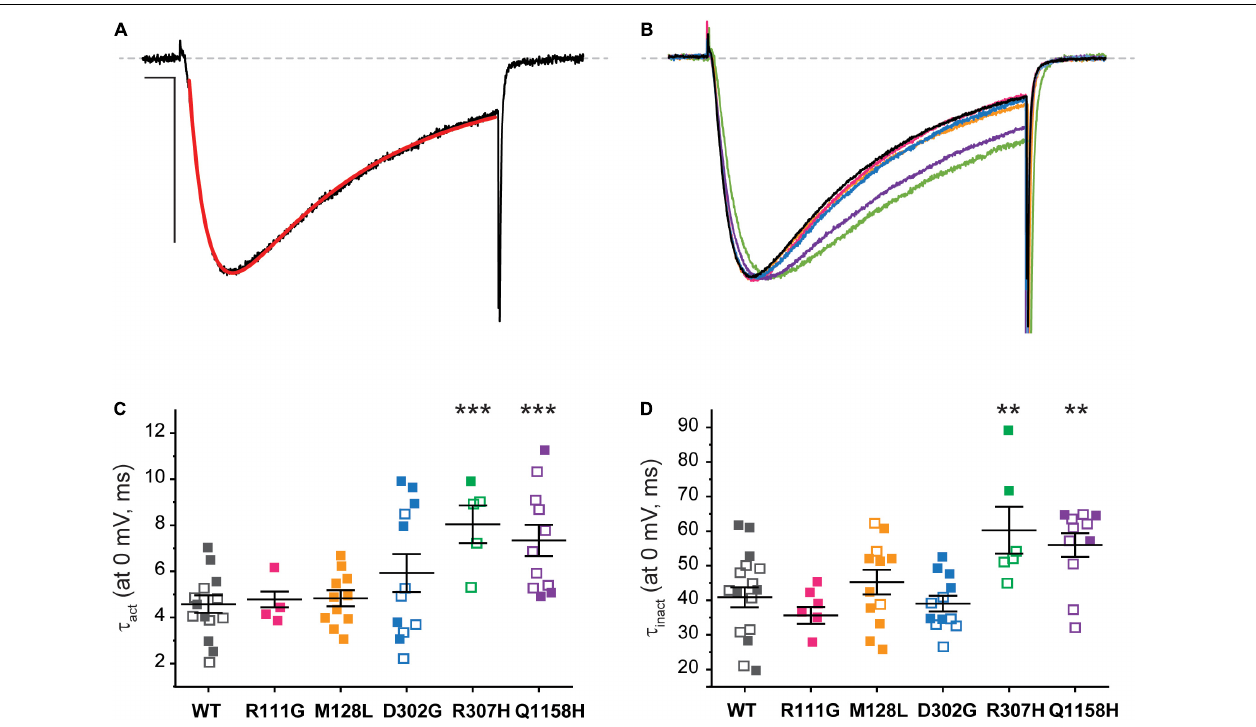
FIGURE 5 | Cav3.3-WT and HM-associated variant current kinetics. (A) The speed of Ca 2 + current activation ( τ act ) and inactivation ( τ inact ) during 100-ms stimuli (inset) was evaluated by fitting (red) the elicited currents with an exponential product equation (bottom), where (C) is the y -intercept. Scale bars: 10 ms, 500 pA. (B) Representative currents from Cav3.3 variants studied. (C) Summary of time constants of current activation ( τ act ). (D) Summary of time constants of current inactivation ( τ inact ). p < 0.001 (***), 0.001 < p < 0.01